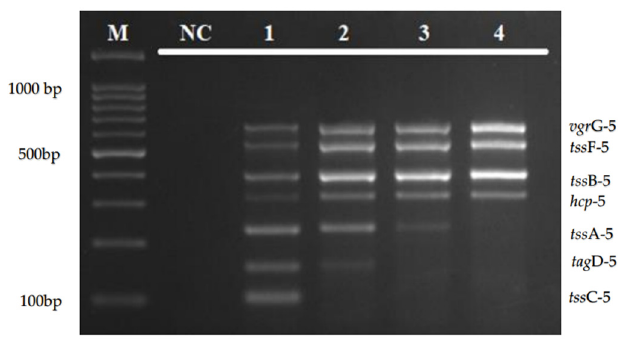
Figure 2. Optimization of primer concentration for tss A-5, tss C-5, and tag D-5 primers. Lane M: 100 bp DNA marker; lane NC: negative control; lane 1: 5.0 µm; lane 2: 2.5 µm; lane 3: 1.25 µm; and lane 4: 0.625 µm.